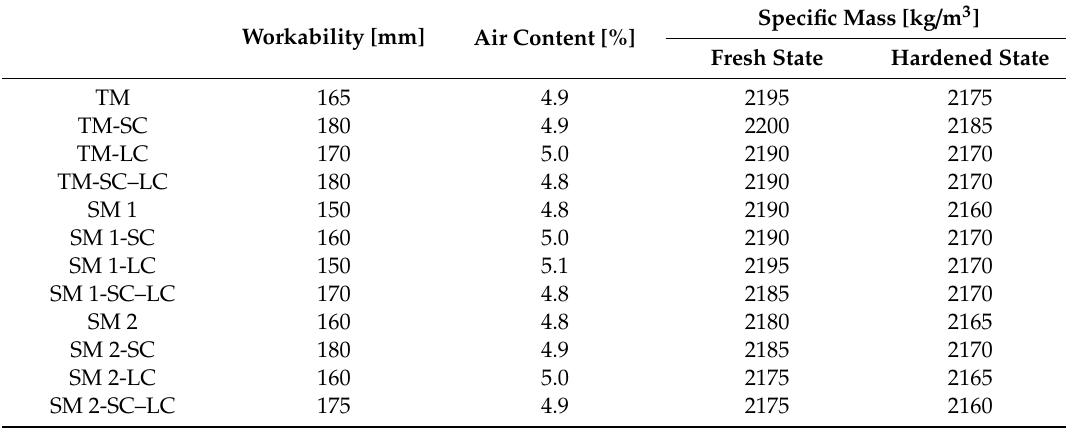
Table 4. Properties of mortars at fresh and hardened